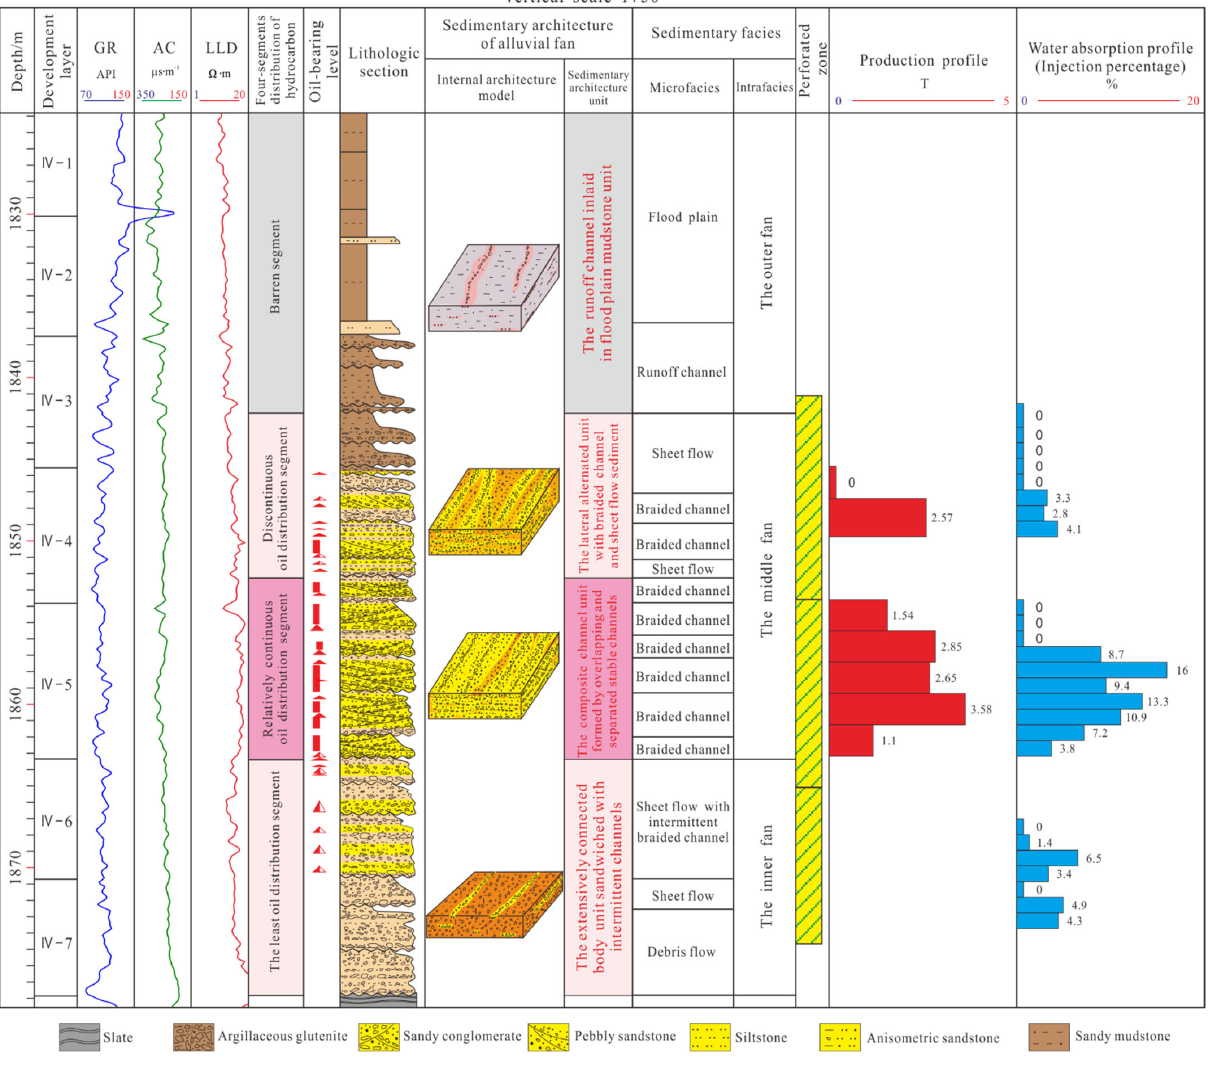
Figure 10. Relationship between production profile and sedimentary architectural units.